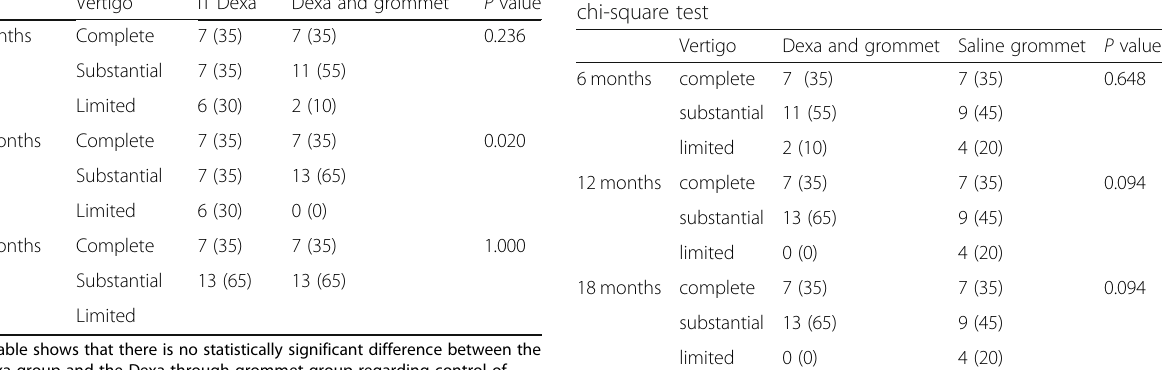
Table 5 Comparing the groups Dexa through grommet group